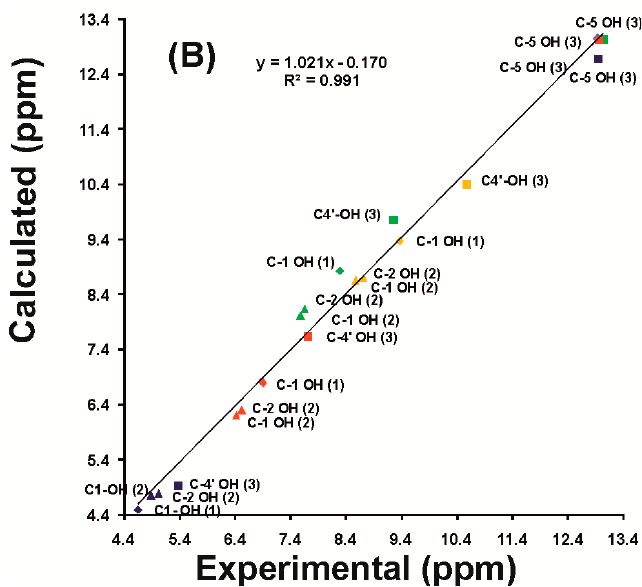
− δ ) of the calculated (at the GIAO exp cal